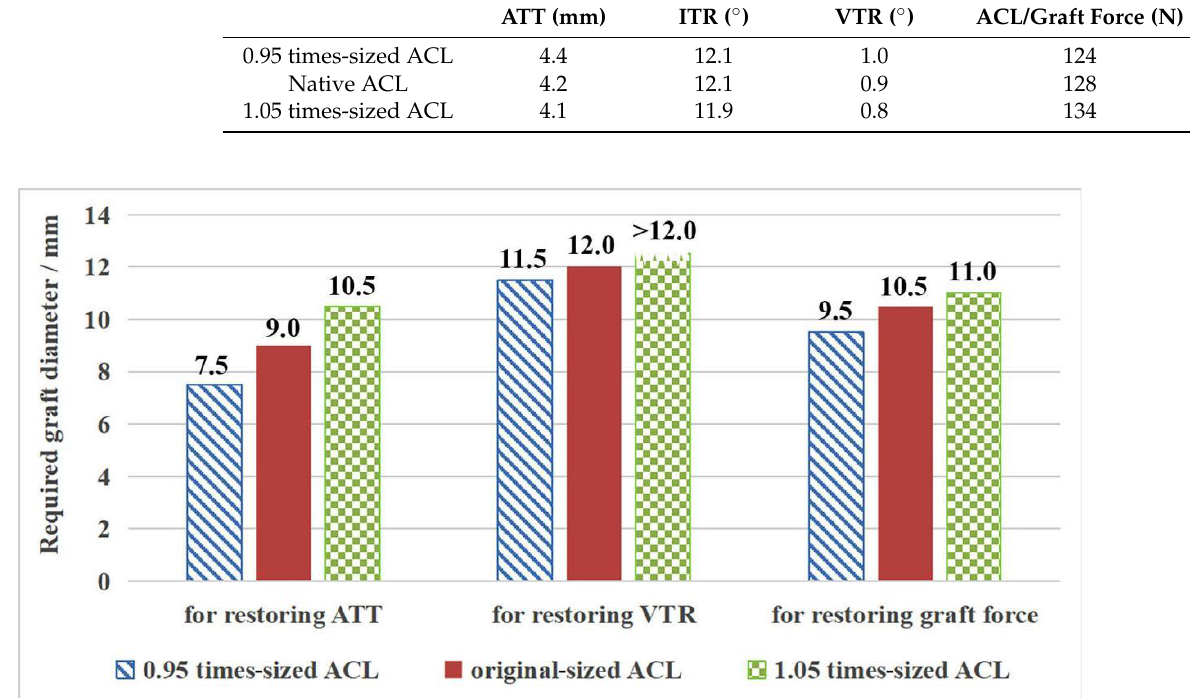
Figure 4. Graft diameters required to restore knee kinematics and graft force, for knees with different-sized native ACL.